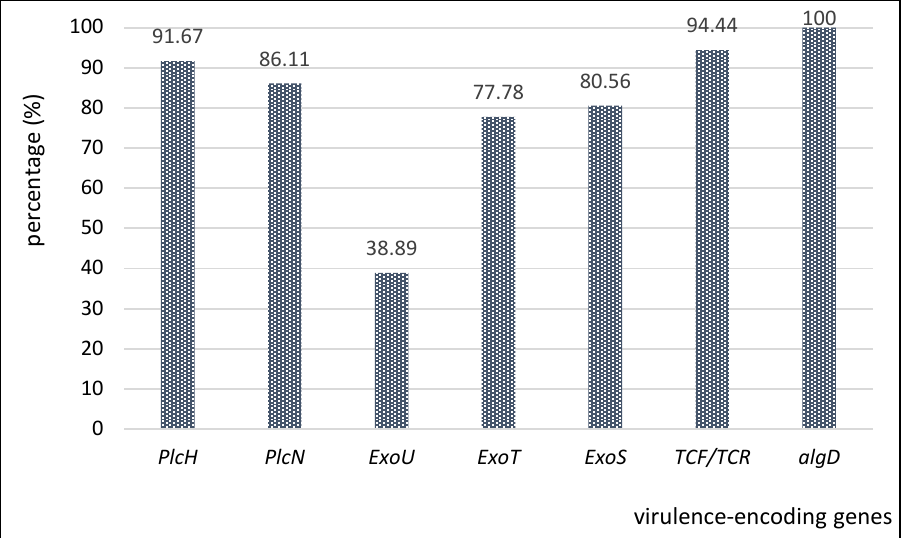
Figure 5. Graphic representation of the distribution of virulence-encoding genes expressed by the P. aeruginosa strains.